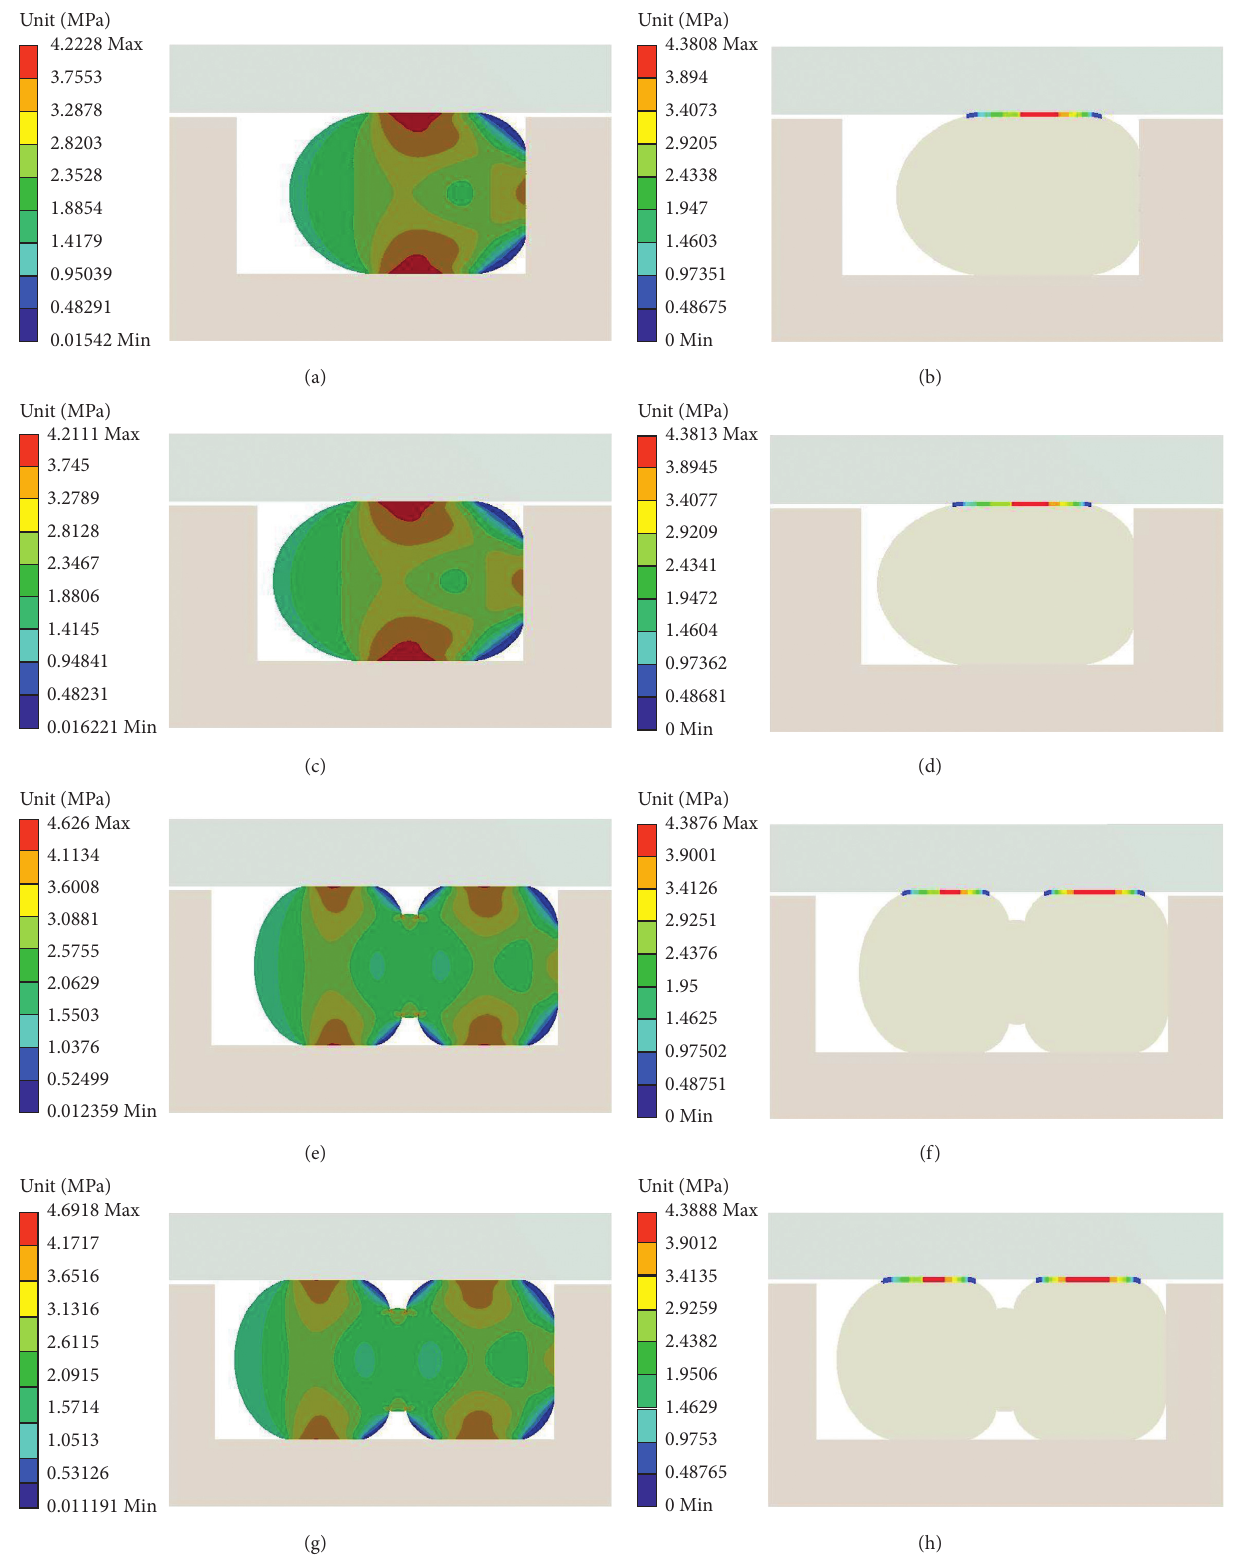
Figure 3: Equivalent stress and contact pressure cloud diagrams of the single-groove